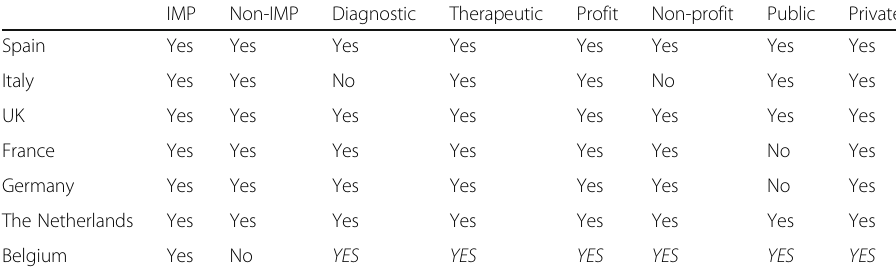
Table 1 GMP requirements for radiopharmaceutical production for clinical trials in Europe IMP Non-IMP Diagnostic Therapeutic Profit Non-profit Public